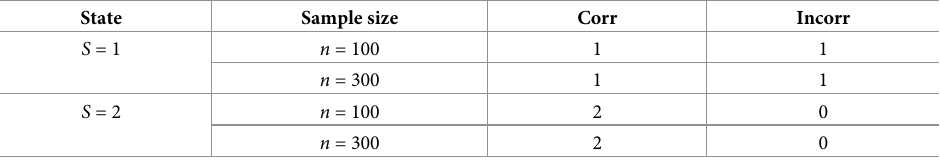
Table 2. Identification results of insignificant variables.